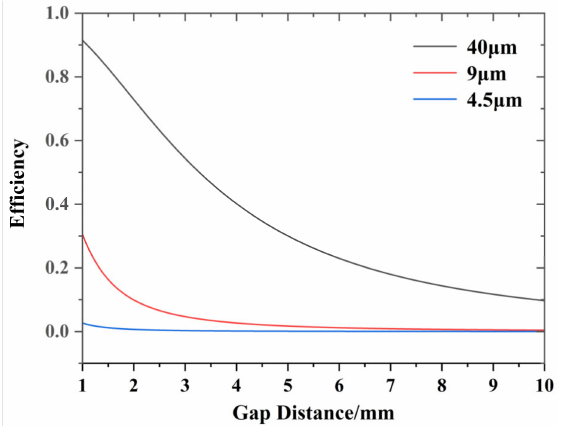
Figure 6. The fiber coupling efficiency with different fiber